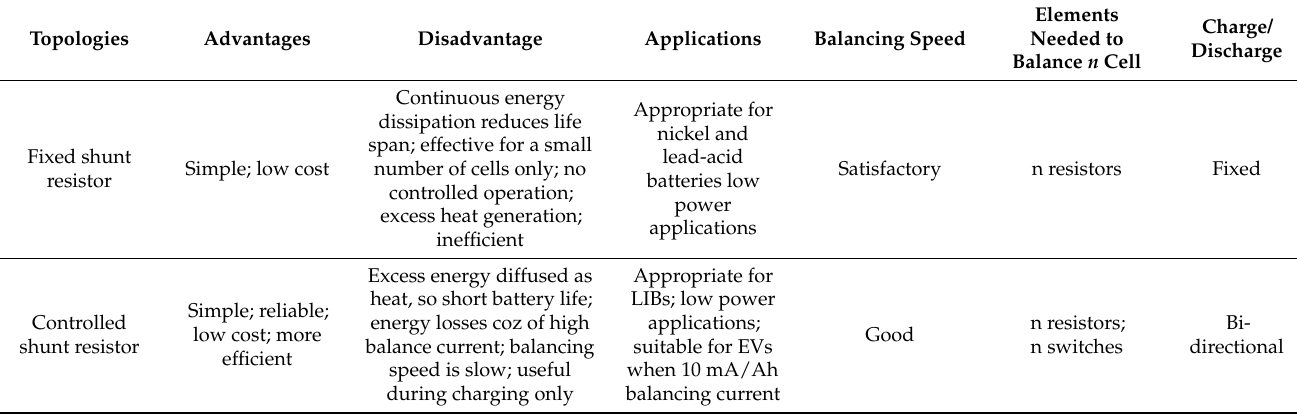
Table 7. Comparison of passive cell balancing techniques [7,48,56].